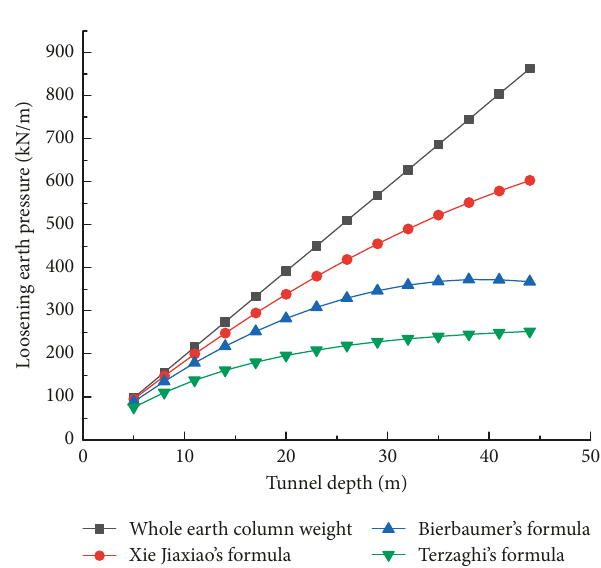
Figure 9: Comparison of vertical earth pressure with tunnel depths using four theoretical formulas in grade VI of the